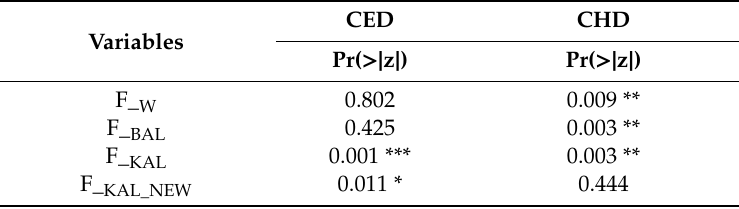
Table 4. Effect of the inbreeding coefficients for the examined traits. Variables